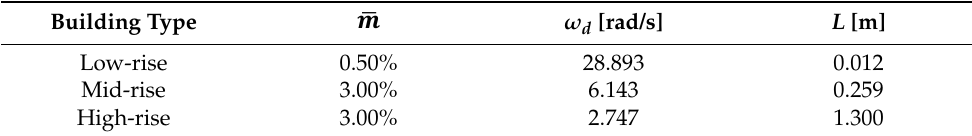
Table 6. Cable length required for the three investigated buildings.